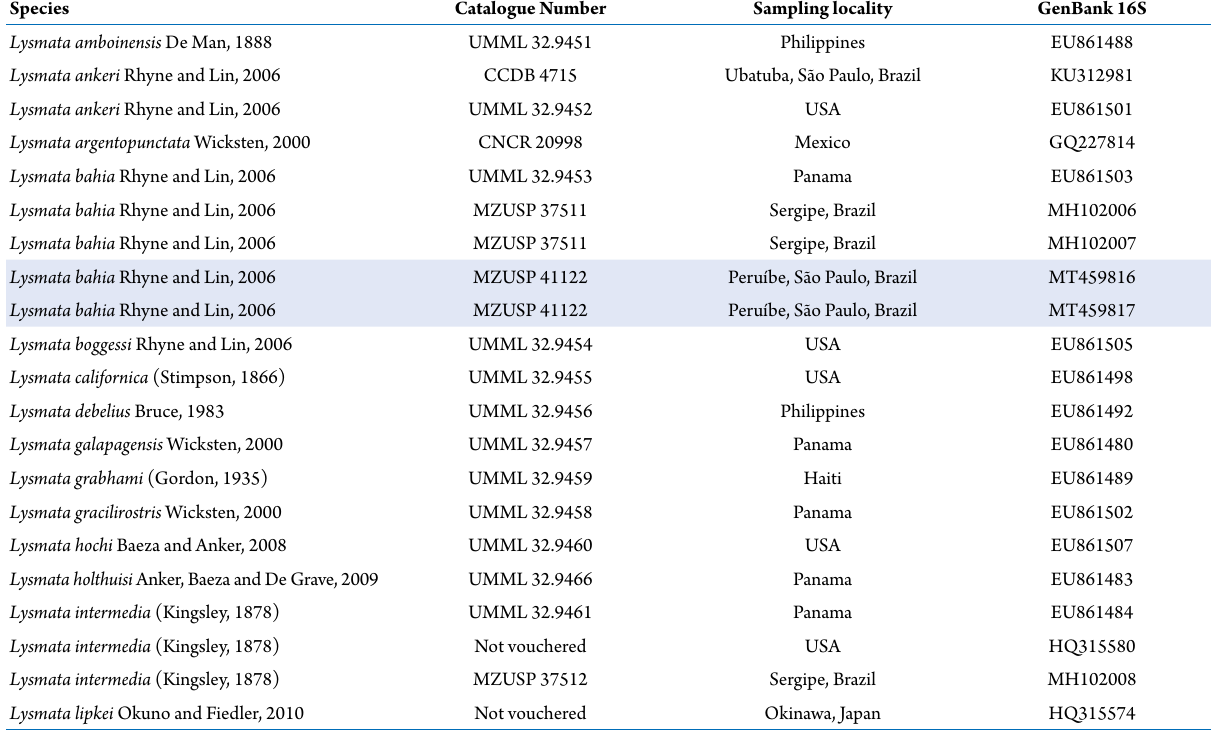
Table 1. Details of specimens and sequences used in the phylogenetic analyses in this study. The new sequences obtained in